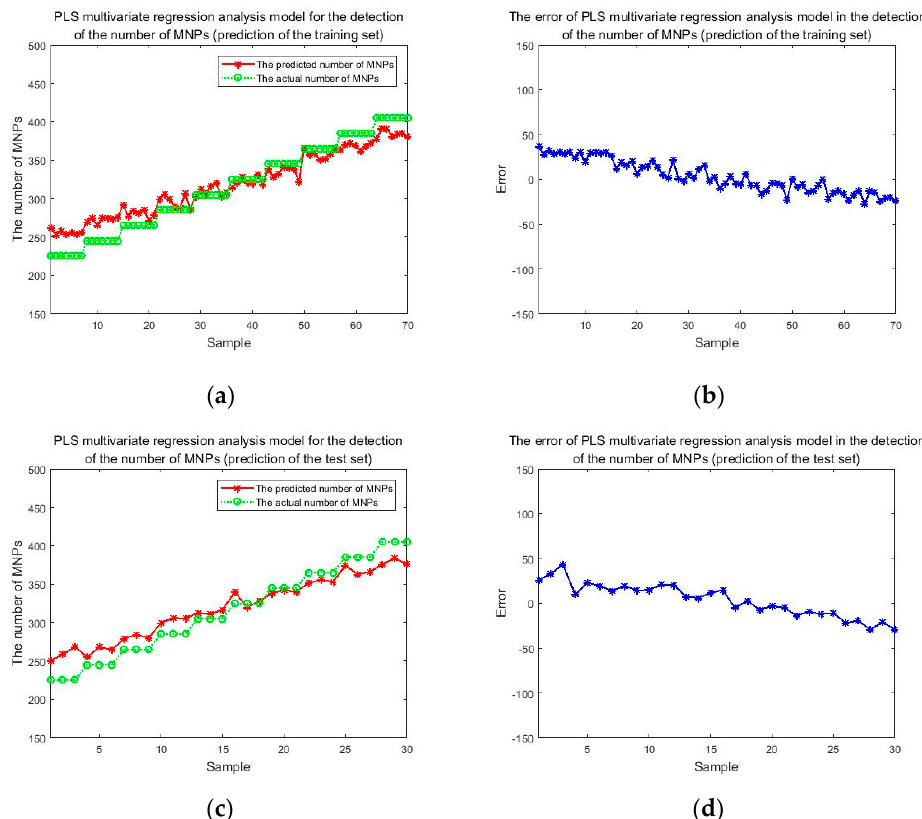
Figure 18. MNPs number detection model based on PLS multivariate regression analysis: ( a ) the prediction results of PLS model for the training set, ( b ) the prediction error of PLS model for the training set, ( c ) the prediction results of PLS model for the test set, and ( d ) the prediction error of PLS model for the test set.